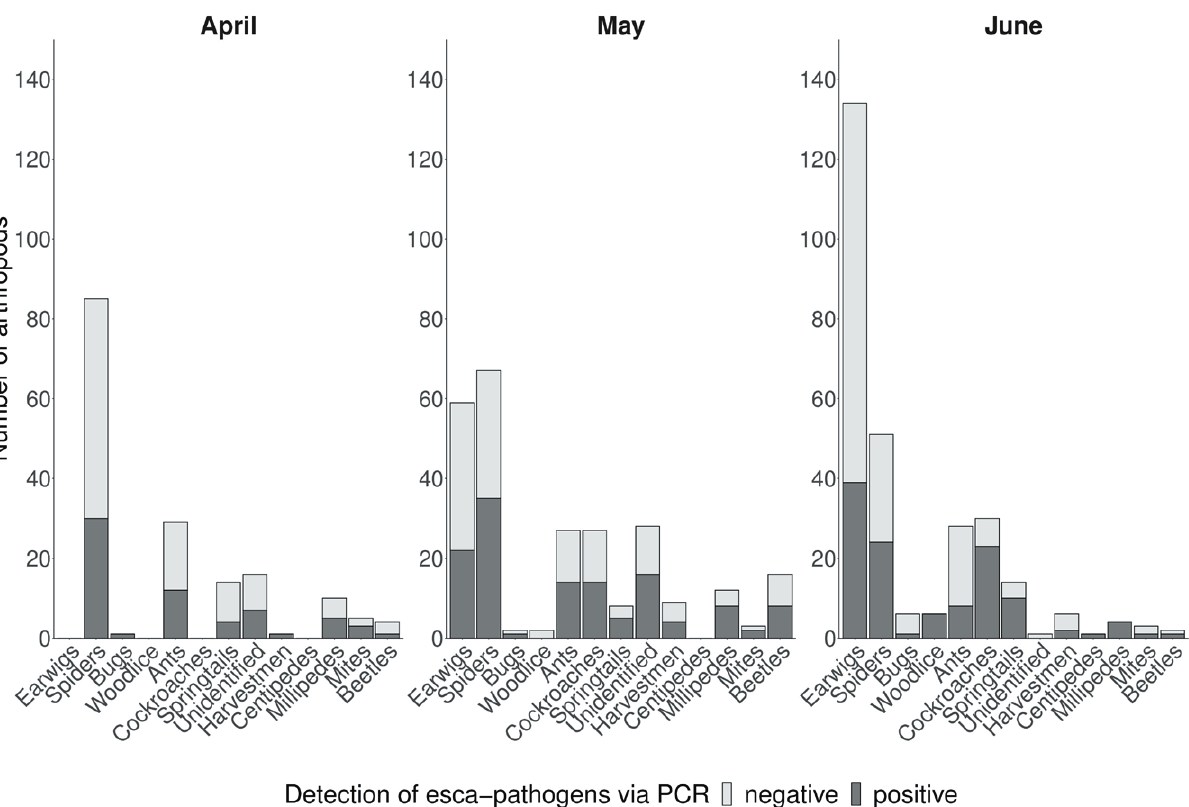
Figure 4. Arthropods testing negative or positive for esca-related pathogens in April, May and June of 2019 and 2020. Arthropods were col- lected from two different vineyards at 2 week intervals using cardboard traps mounted to grapevine